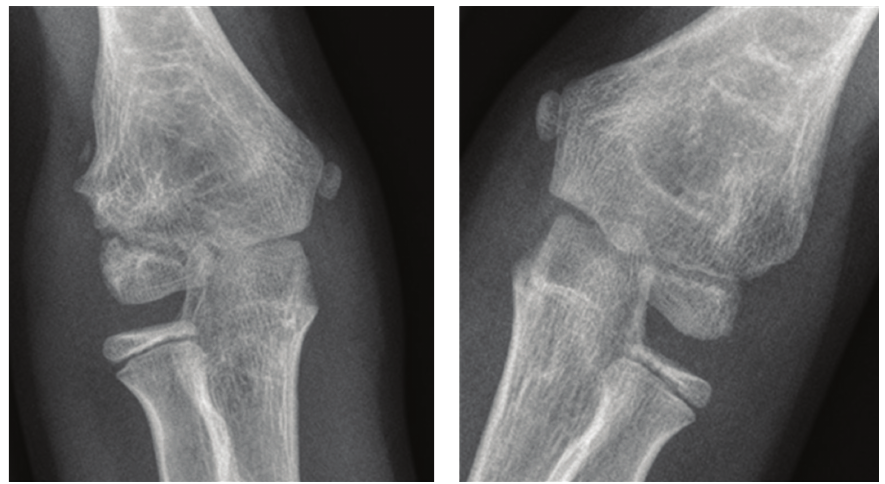
Figure 2: Fractured elbow compared to the contralateral healthy elbow at 4-year followup (group